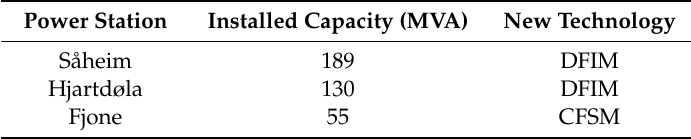
Table 4. Varied speed installations in the NPS model in the year 2030.